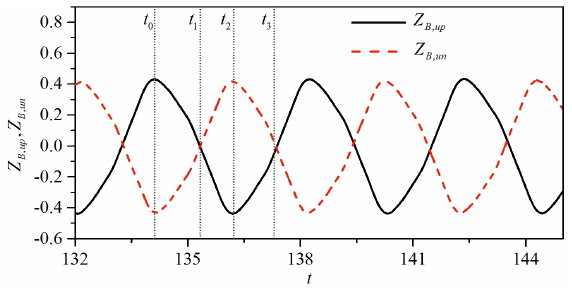
Figure 12. Time evolutions of the transverse displacements of points B 1 and B 2 at G z = 3.0.